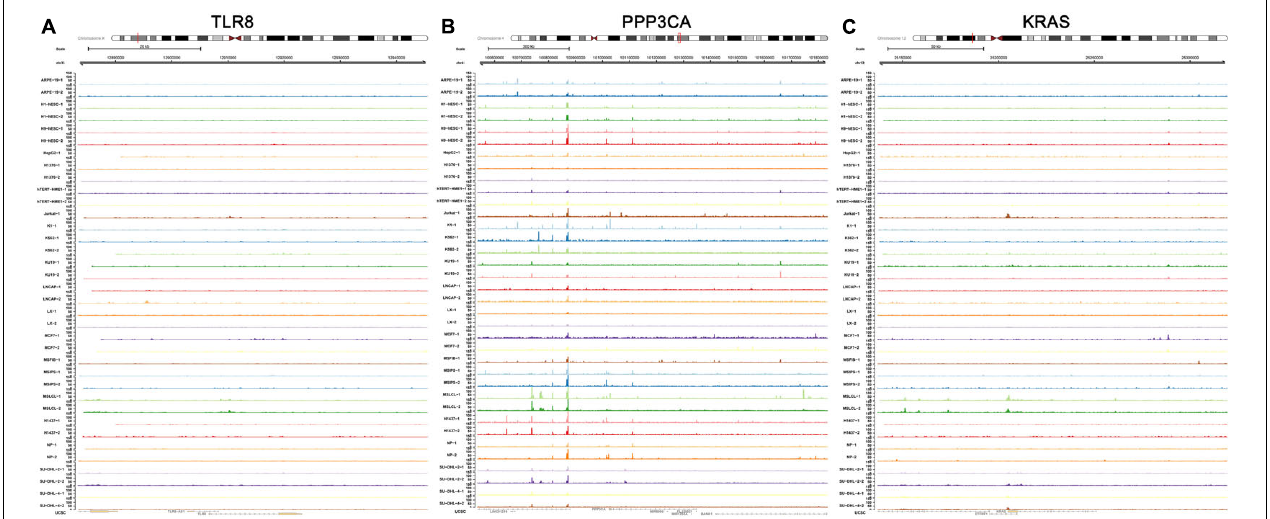
FIGURE 7 | Validation of three key IRGs (TLR8, PPP3CA, and KRAS) in ATAC-seq data available from GSE139099. Binding peaks of three key IRGs [TLR8 (A) , PPP3CA (B) , and KRAS (C) ] in ATAC-seq data of 24 different cell lines from a variety of tissues were visualized by